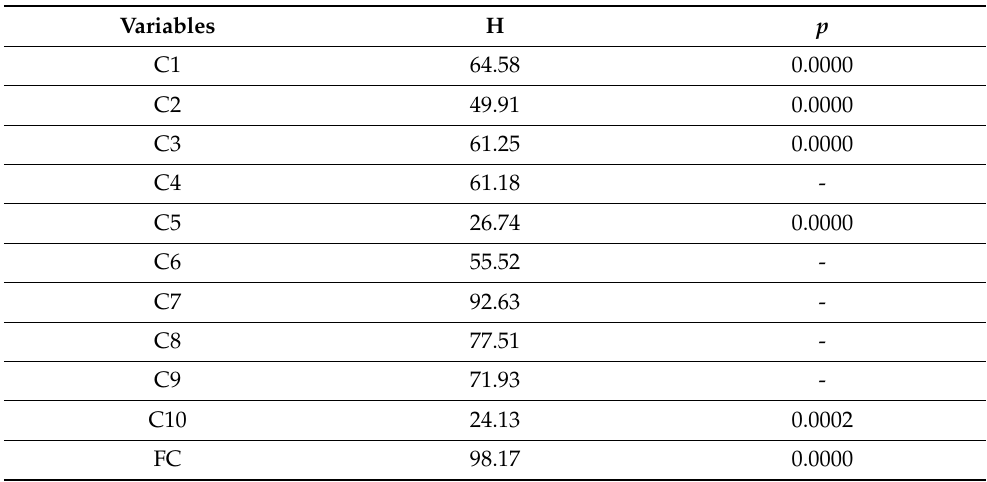
Table 6. The results of the ANOVA Kruskal-Wallis test for differences in the functioning of the creative sector between the city